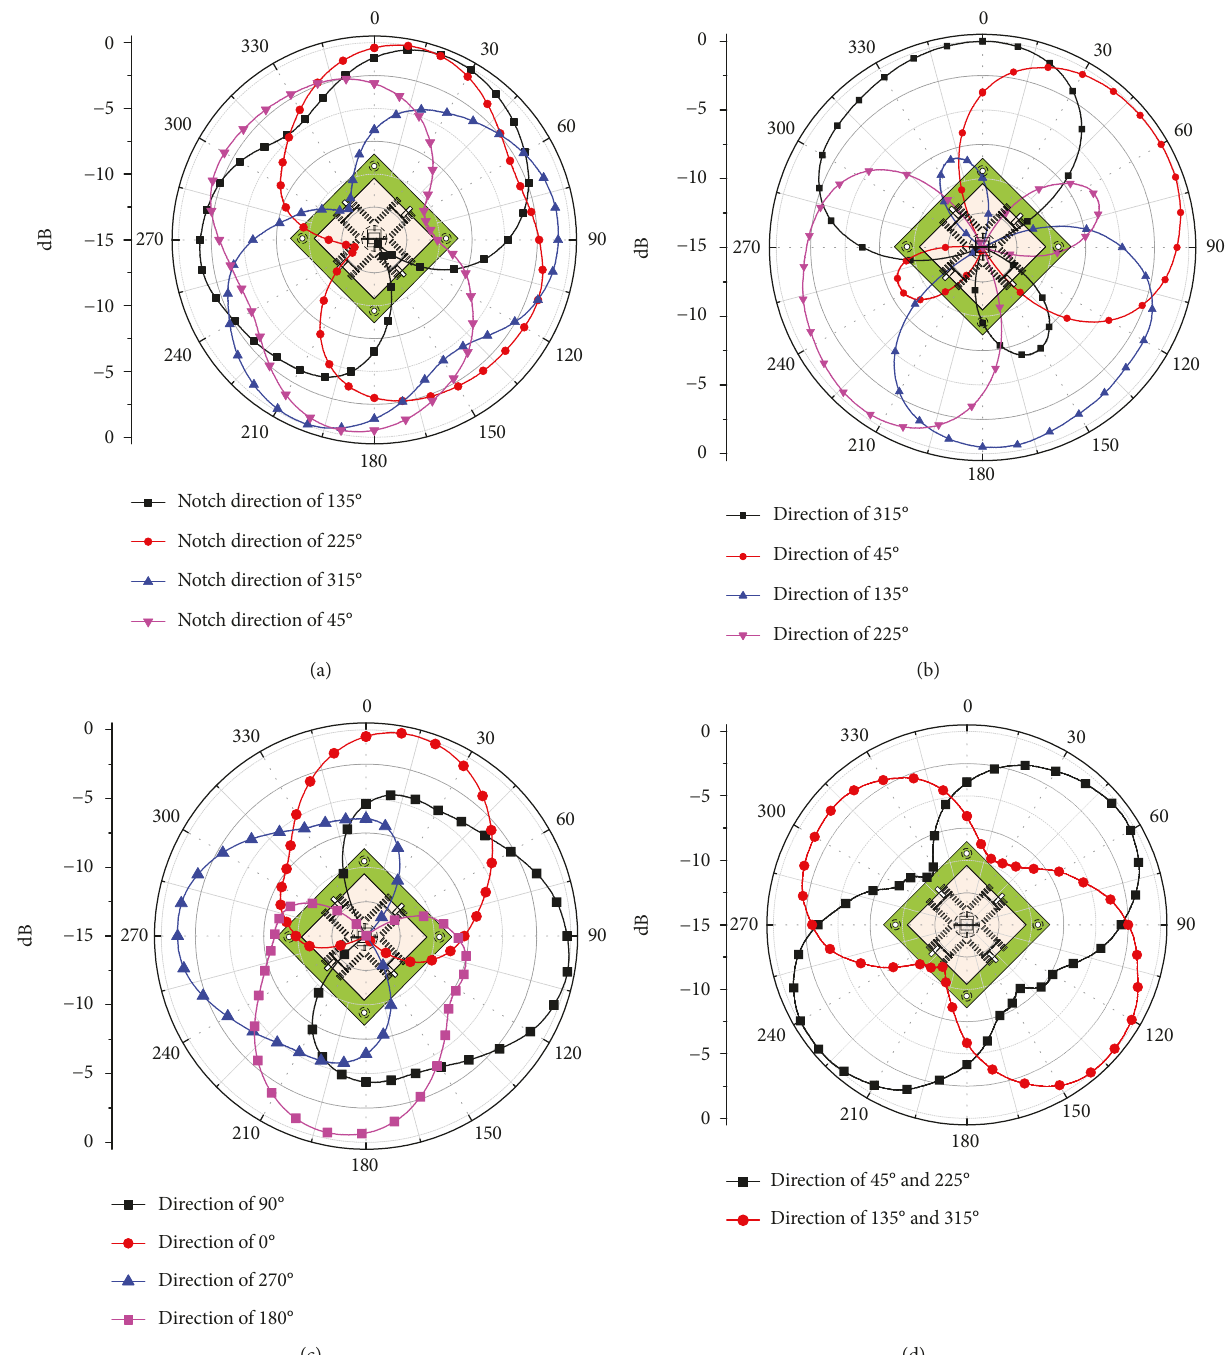
Figure 8: Measured patterns of the four states at 5.2GHz, (a) state III, a re fl ector and three directors, (b) state IV, three re fl ectors and a director, and (c) state V, two re fl ectors and two directors, which are adjacent (d) state VI, two re fl ectors and two directors, which are not